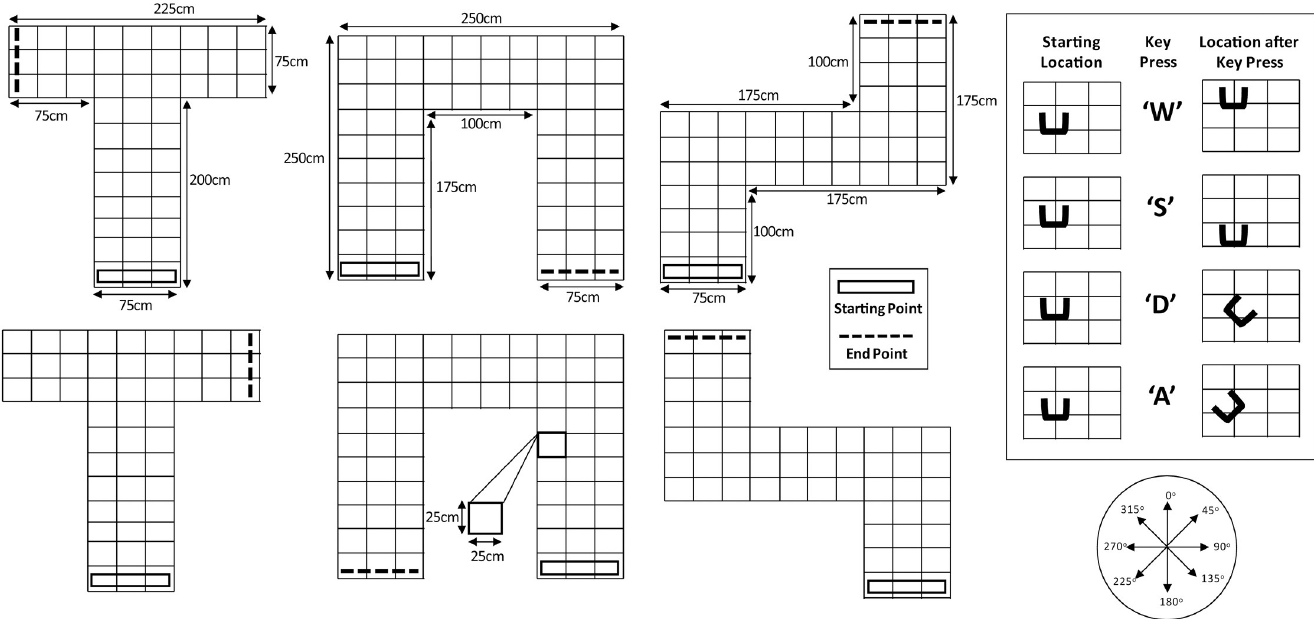
Fig 4. Illustration of spatial arrangements used to construct virtual spaces (T-mazes, U-mazes, Z-mazes) for the virtual navigation task. In all mazes, the box represents the starting area and the dashed black line symbolises the end point which sounded echo-acoustically different because it had been constructed from corrugated plastic sheets. For each position (i.e. intersection in each route) there were eight sound recordings (0˚–315˚ in 45˚ steps). To navigate, participants used the computer keyboard (inset on the right-hand side). Each press of the ‘W’ key would move the participant one step forward in the virtual maze and the ‘S’ key would move them one step backwards, but still facing in the same direction. Each press of the ‘D’ key would rotate the participant 45˚ in clockwise direction and the ‘A’ key would rotate them 45˚ anti-clockwise.